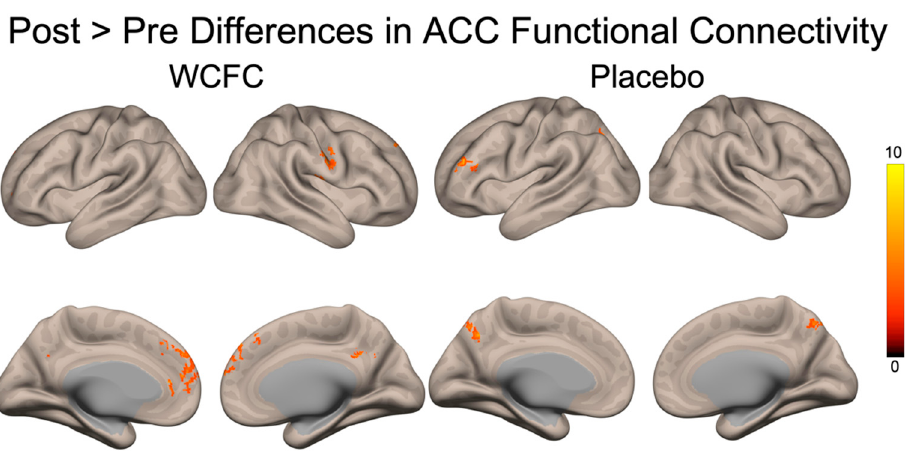
Figure 5. Anterior cingulate functional connectivity differences (post > pre) during the n-back task. WCCE showed greater connectivity post-consumption between the ACC and the paracingulate, the precuneus, and portions of the superior frontal gyrus and frontal poles. The placebo demonstrated a greater connectivity between the ACC and portions of the left dorsolateral prefrontal cortex, as well as the precuneus. Data were thresholded with p uncorrected < 0.01 height threshold, p FDR-corrected < 0.05 cluster threshold, one-tailed.